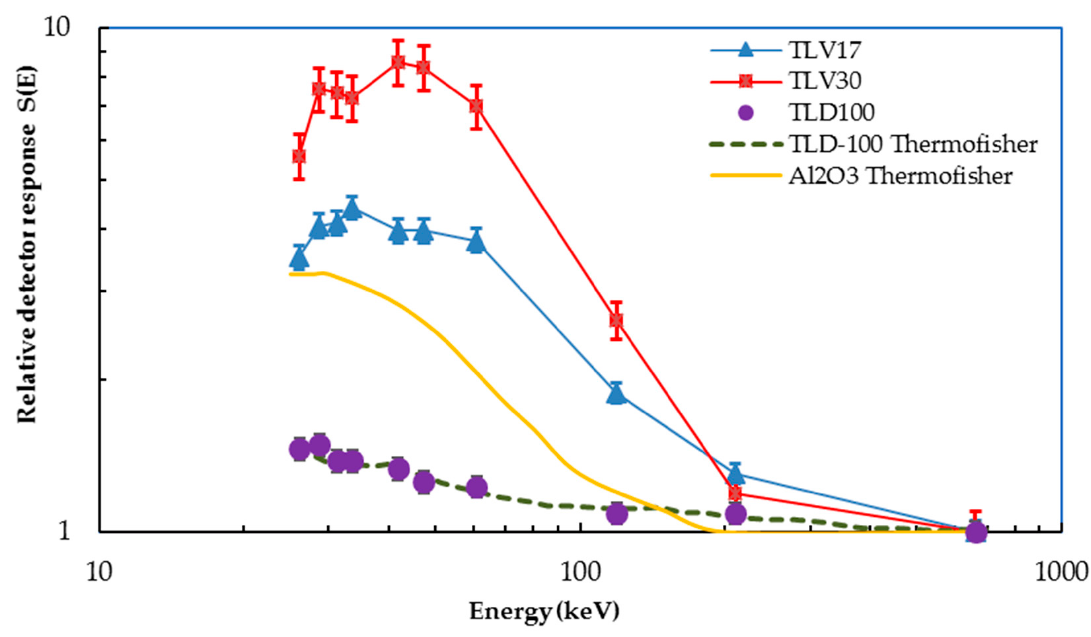
Figure 11. Energy dependence of TLV17, TLV30 and TLD-100.